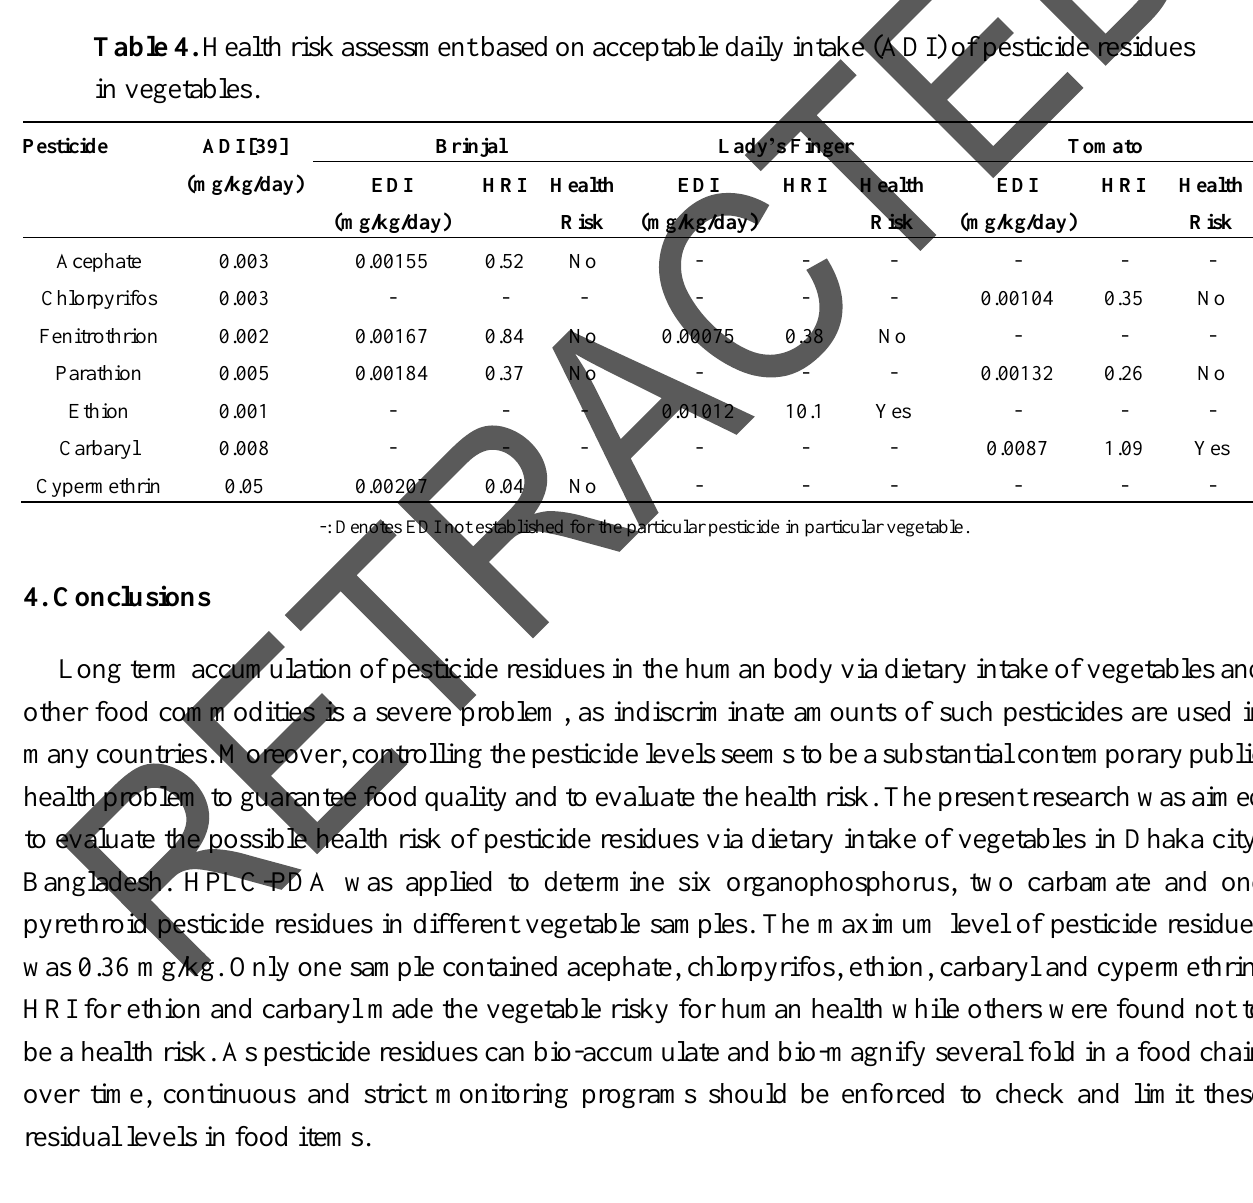
Table 4. Health risk assessment based on acceptable daily intake (ADI) of pesticide residues in vegetables.